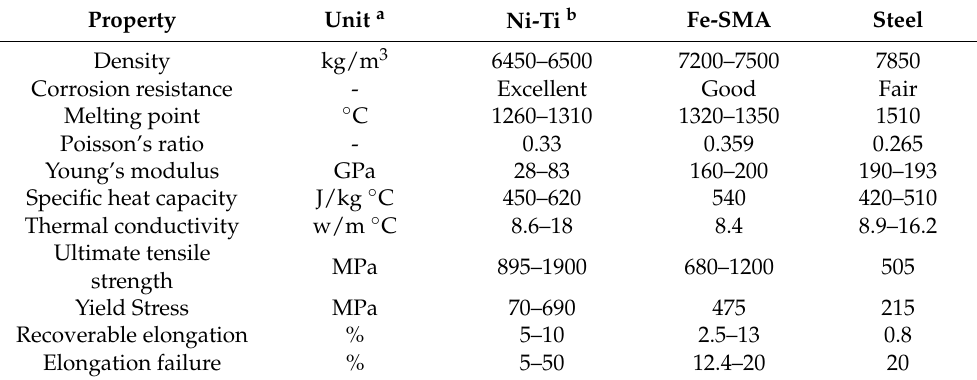
Table 1. Comparison of physical and mechanical characteristics of Ni-Ti and Fe-based SMAs, and stainless steel